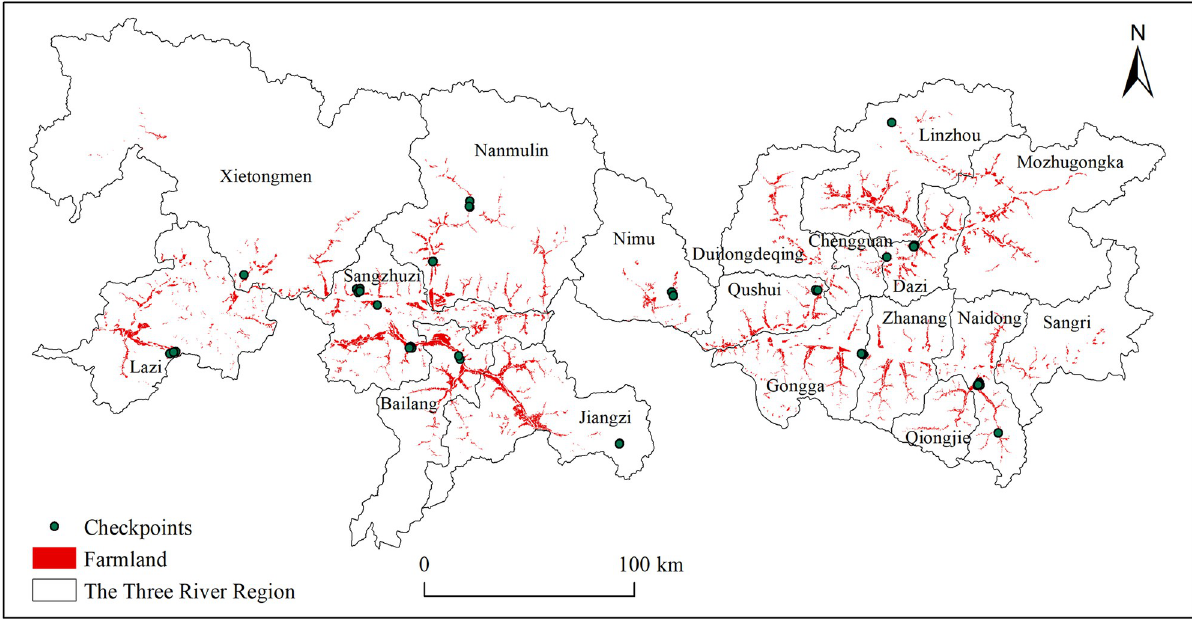
Fig 3. Spatial distribution of 55 farmland checkpoints in the Three River Region. The map was prepared with ArcGIS10.1 (https://resources.arcgis. com/en/help/), based on the maps of China political boundaries from the Resource and Environment Science and Data Center, CAS (https://www. resdc.cn/), with the permission of its copyright, checkpoints and farmland data from Wei et al., [34] (https://doi.pangaea.de/10.1594/PANGAEA. 937400).